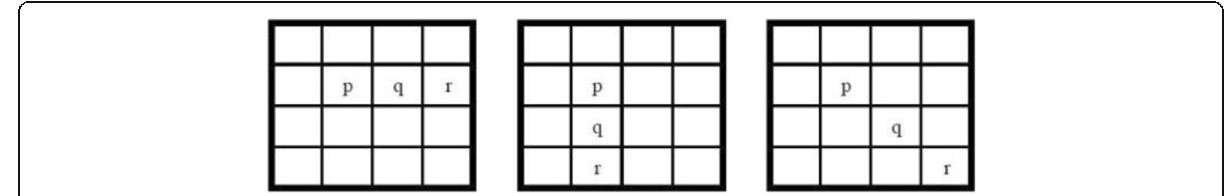
Fig. 3 Conditional probability orientations: horizontal, vertical and diagonal